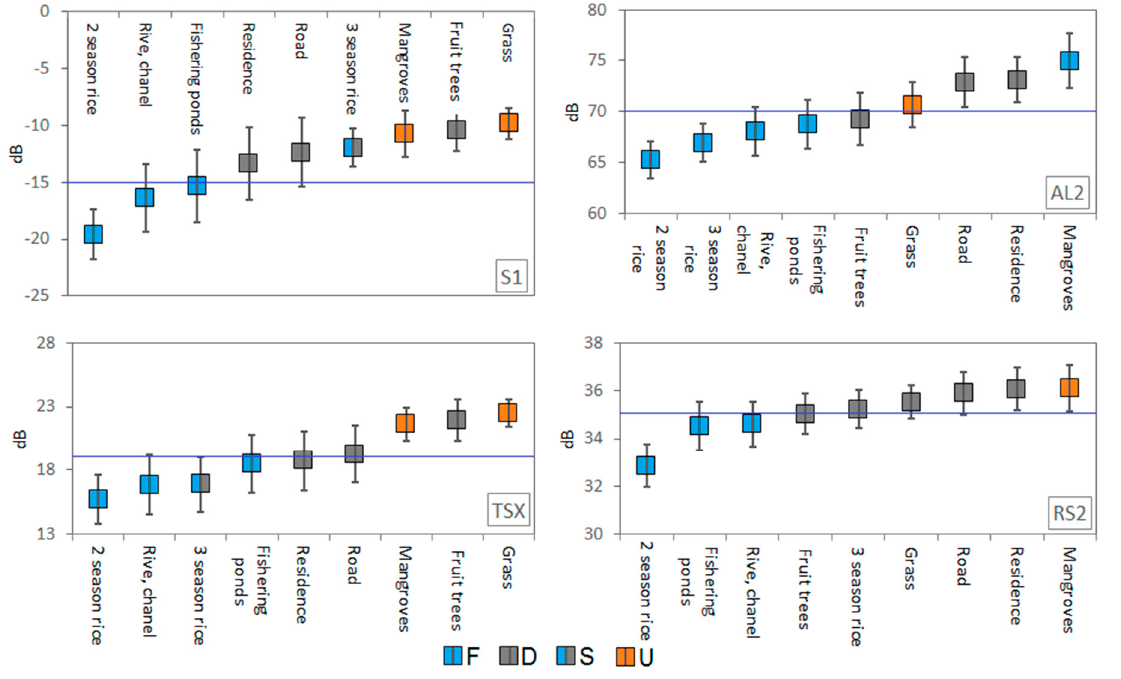
Figure 9. Mean sigma0 dB values and standard deviation (STD) of the major LULC classes in Tam Nong. F: flooded; D: dry; S: semi-flooded (some plots were underwater whereas other plots were dry); U: remains unidentified.